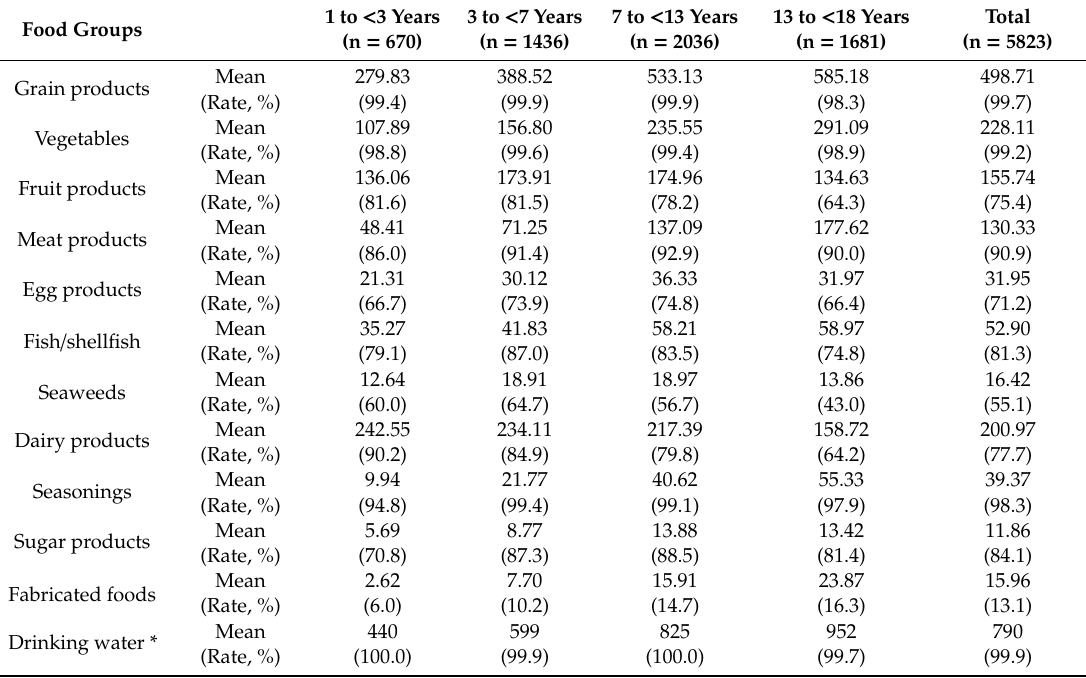
Table 5. Average daily intake (g / day) and consumption rate (%) of major